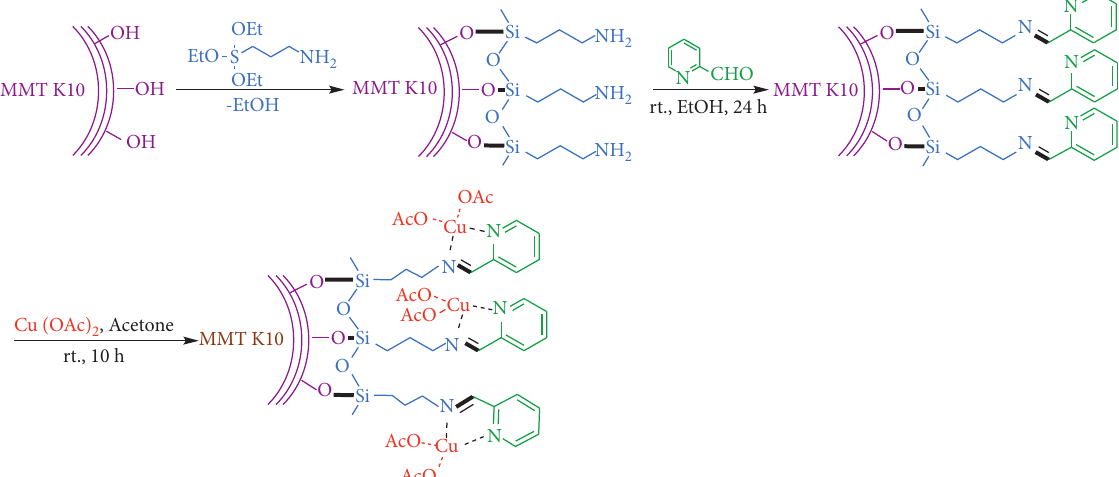
Scheme 2: Preparation of copper(II) anchored on modified MMT